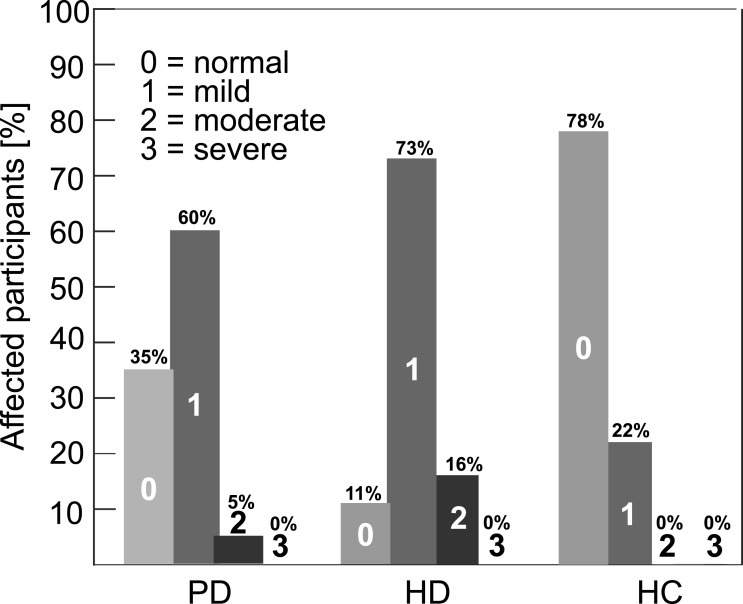
Percentage occurrence of hypernasality across participants according to the four grades perceptual score (0, no; 1, mild; 2, moderate; 3, severe) based on GOS.SP.ASS.’98 (Sell, Harding & Grunwell, 1999).